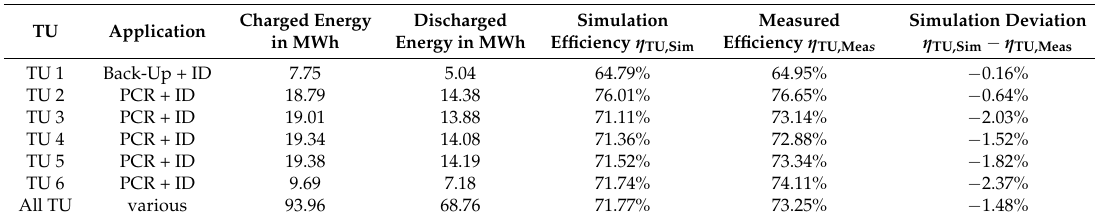
Table 2. Charged/discharged energy and simulated/measured round-trip energy efficiency for Technical Units 1–6 for March